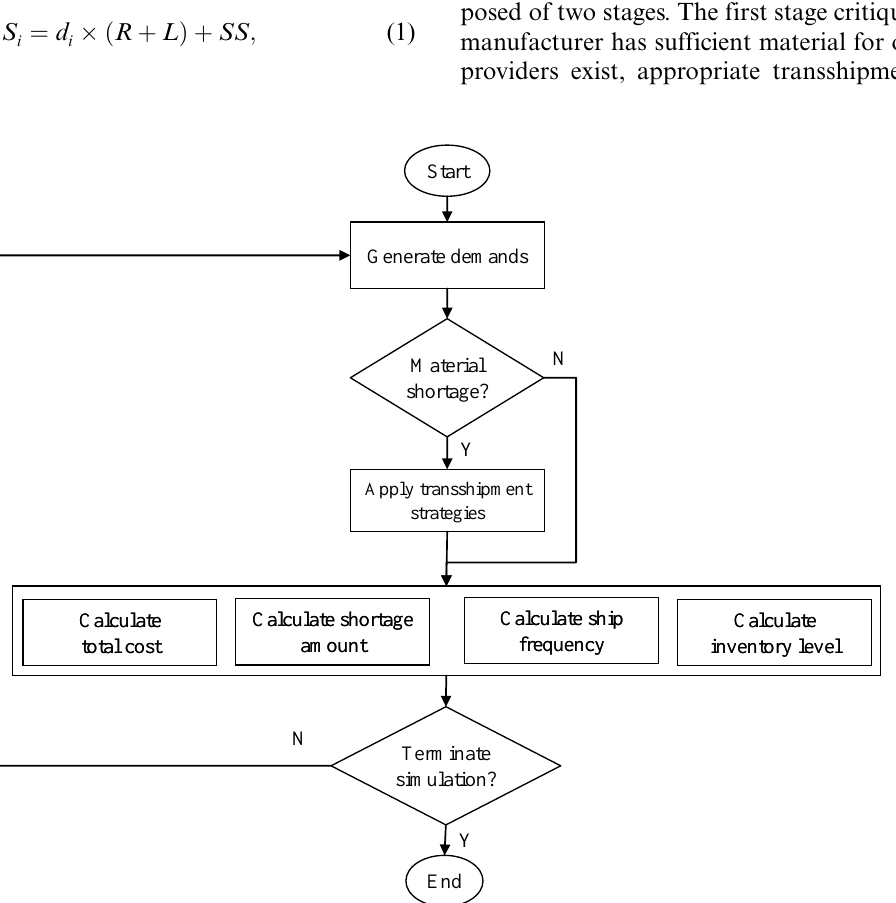
Fig. 6. Simulation